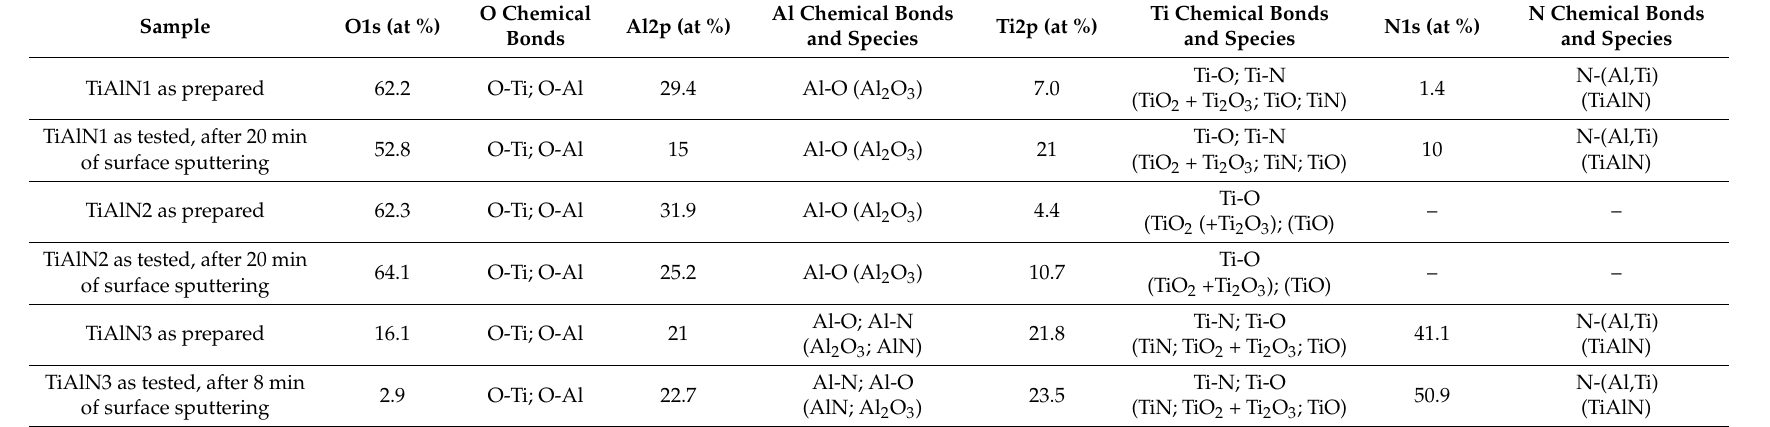
Table 3. XPS surface analysis after 40 cycles up to 950 ◦ C, comparison after different sputtering